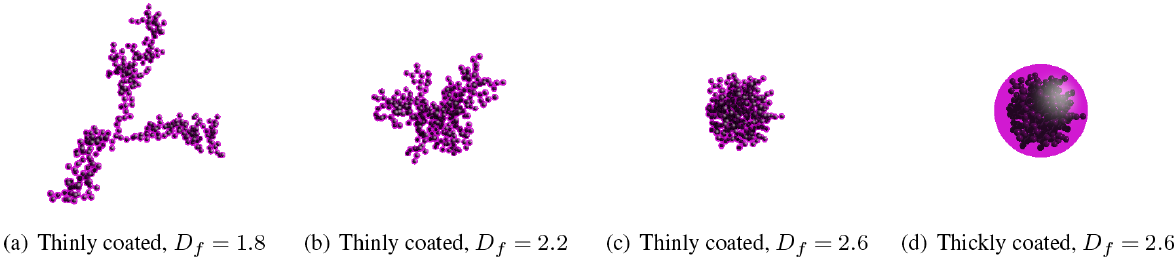
Figure 1. Typical morphologies of BC, n s = 300 ,k 0 = 1 .